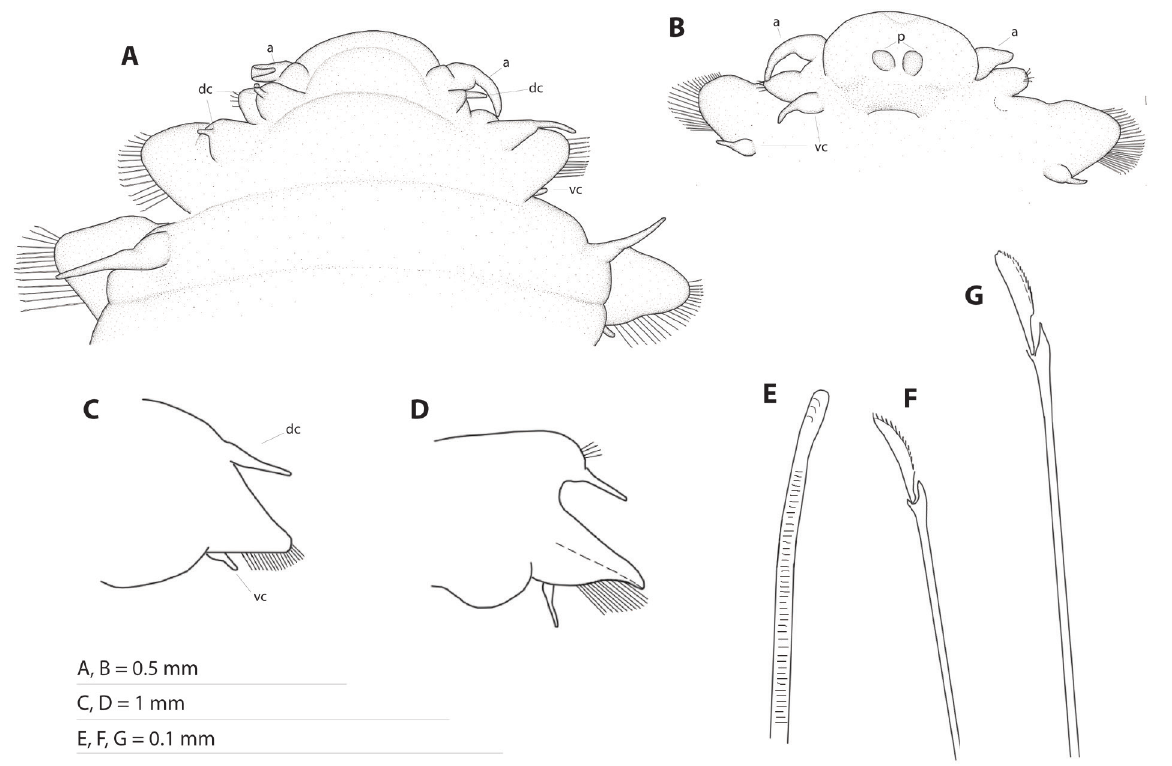
Fig. 3. Craseoschema thyasiricola gen. et sp. nov. Line drawings. A . Anterior end, dorsal view. B . Prostomium, ventral view. C . Third parapodium, posterior view. D . Median parapodium, posterior view. E . Notochaeta from median parapodium. F . Ventralmost neurochaeta from the second parapodium. G . Dorsalmost neurochaeta from median